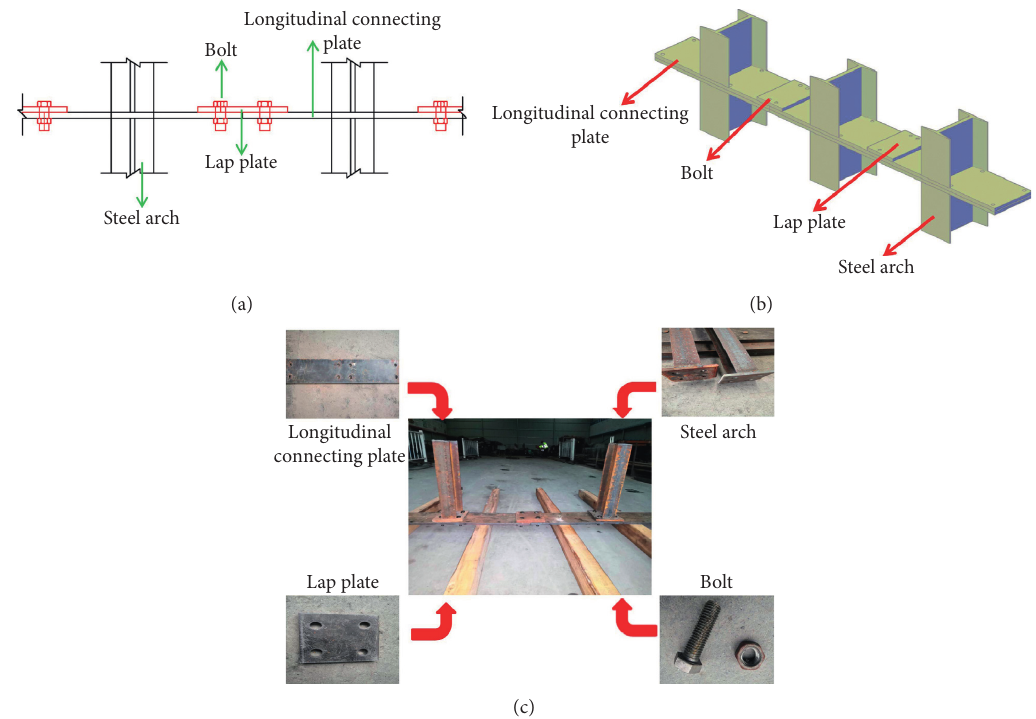
Figure 14: New longitudinal connection system: (a) schematic diagram of the new longitudinal connection system; (b) three-dimensional drawing of the new longitudinal connection system; (c) site assembly photos of the new longitudinal connection system.